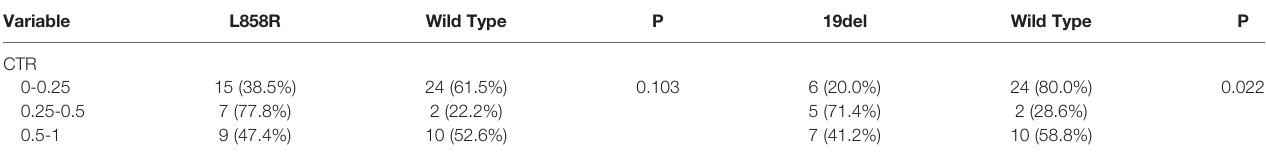
TABLE 3 | Association between the Proportion of EGFR mutation and CTR features.